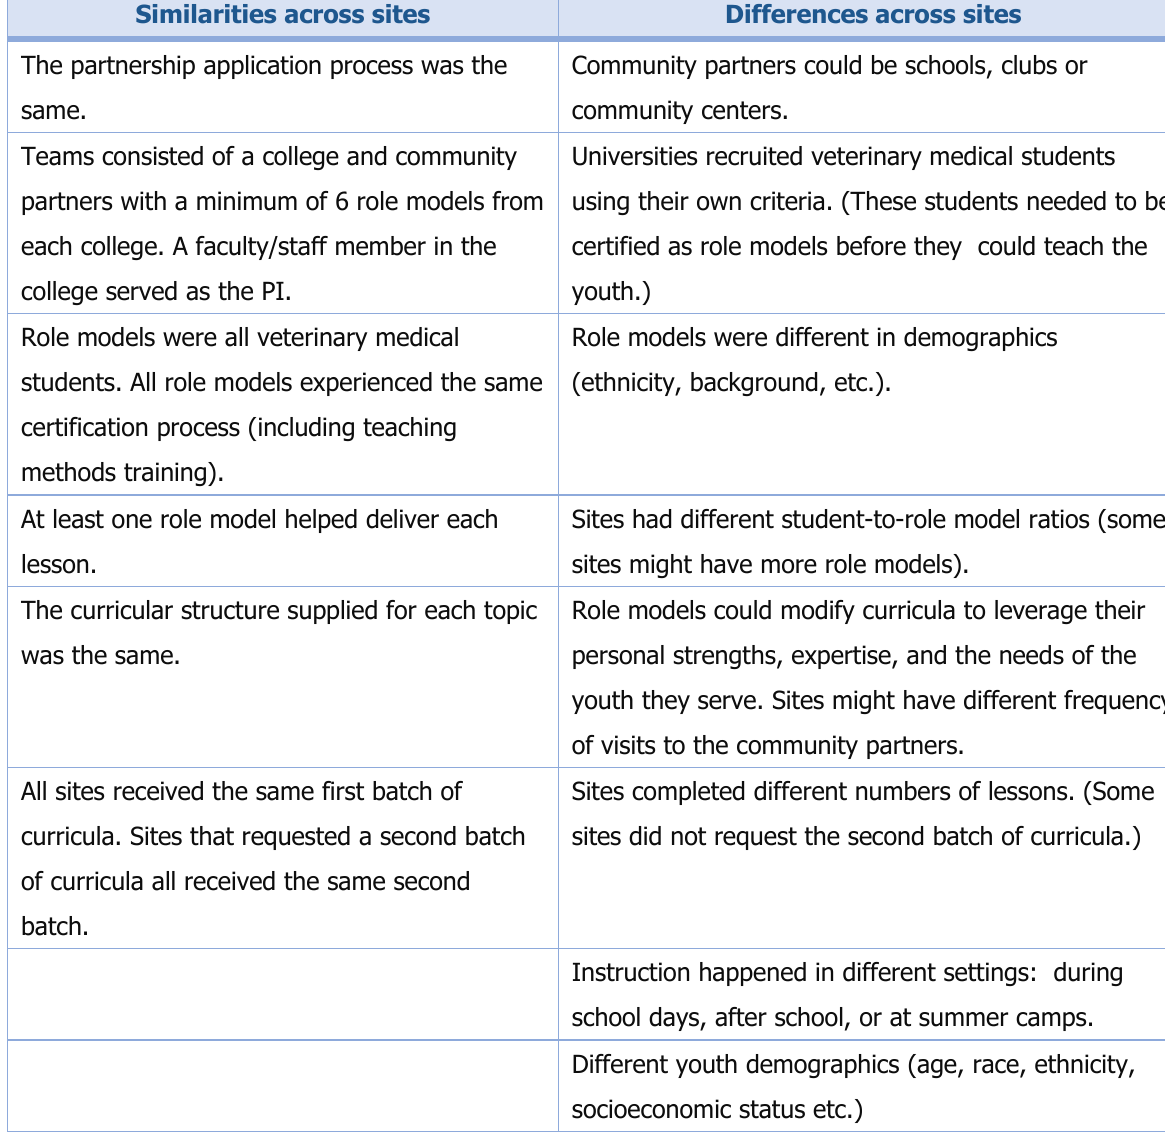
Table 1. Similarities and Differences Across